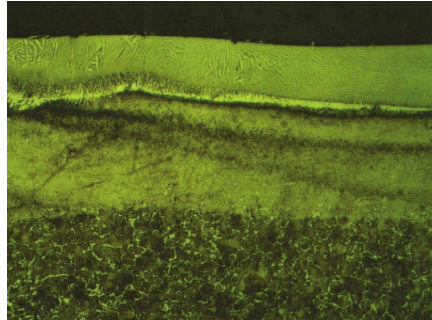
Figure 9: The image of the metallographic structure of surface layer after the EDA: U = 200 (V), I = 32 (A), Ti = 3200 ( μ s) (x 250).